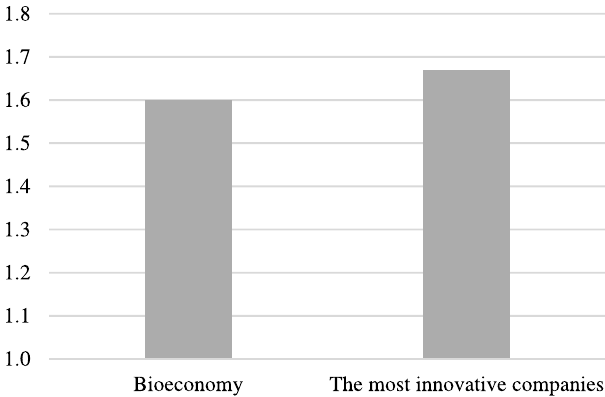
Fig. 2 Average degree of education using the mode approach. The mode approach illustrates that the average number of degrees in the boards of directors ’ is slightly higher for the most innovative companies (1.67) compared to the bioeconomy companies (1.60). Table 2 Education degree held most using the mode approach.